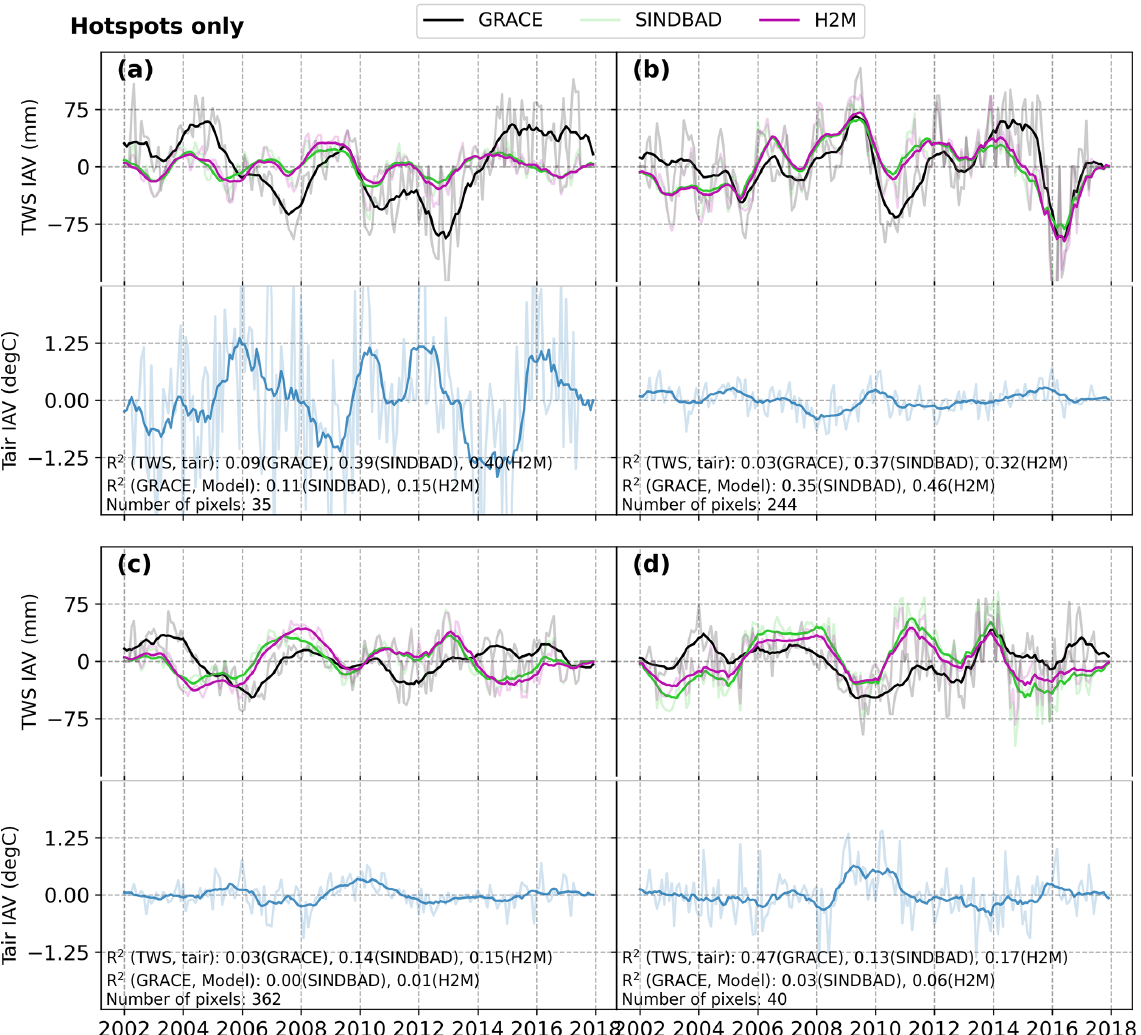
Figure B9. Same as Fig. 6 but using air temperature ( T air ) IAV instead of precipitation (PPT) IAV.